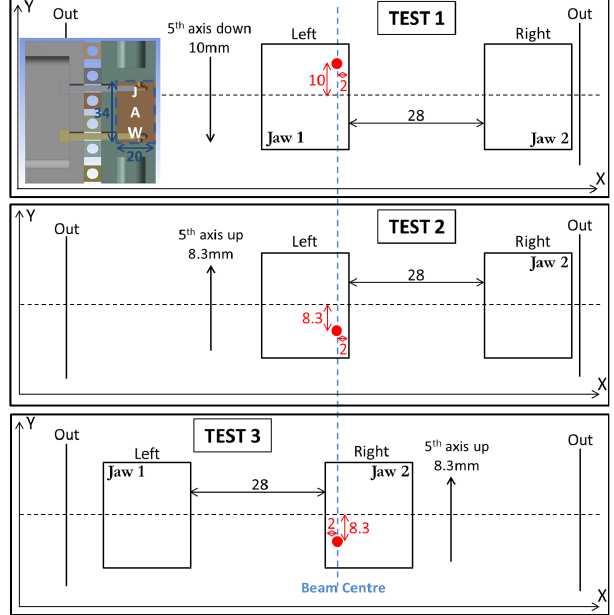
FIG. 7. Schematic diagrams for Tests 1 – 3. The schematic diagram of the jaw represents the area enclosed within the dotted blue line as shown here and in Fig. 3. The impact location is shown in red and all dimensions are in mm.